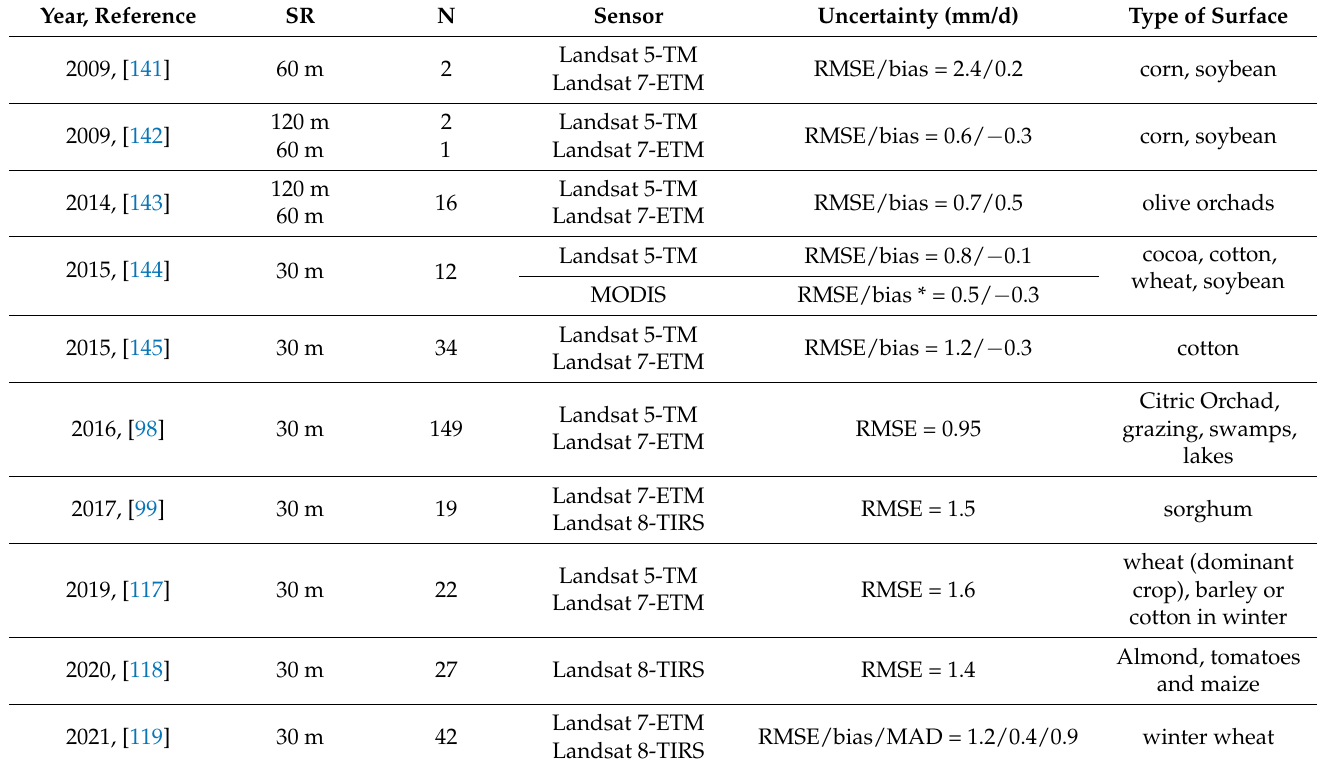
Table 4. Representative chronological compendium of validation studies of the METRIC algorithm. Reference, spatial resolution (SR), number (N) of satellite scenes, Sensor Name, Uncertainty and Type of Surface are detailed (uncertainty statistics are averaged values of all type of surface studied). Statistical uncertainties Root Mean Square Error (RMSE), and bias, are shown for ET d (mm/d). Different uncertainty rows inside the cell means uncertainty associated to the satellite